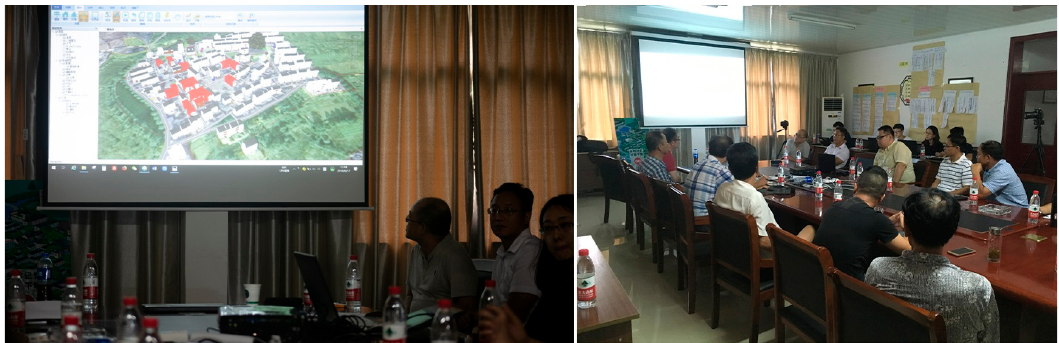
Figure 8. Conflict resolving based on on-site discussion using